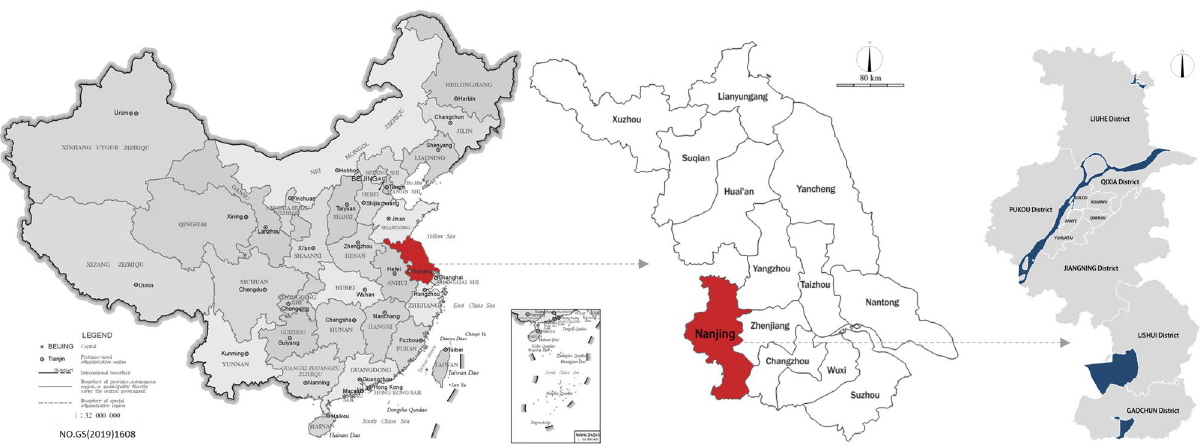
Figure 4. Location of the city of study in China’s map. Source Author made through tianditu JavaScript API 4.0 open access platform (http:// lbs. tiand itu. gov. cn/ api/ js4.0/ opens ource/ source. html).